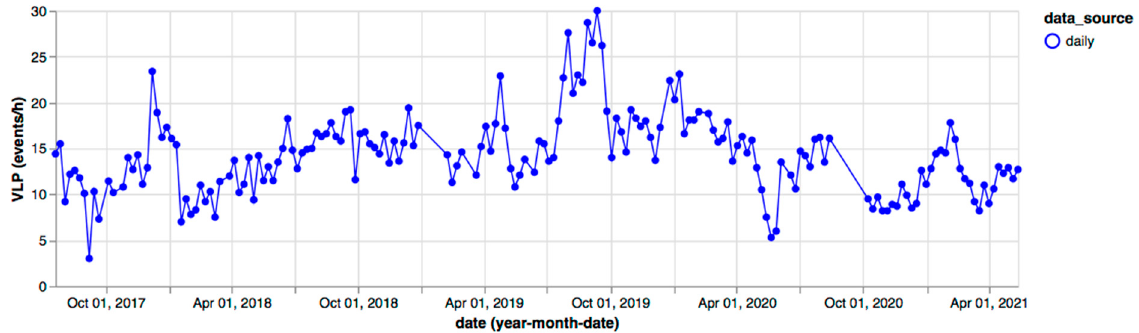
Figure 14. VLP time series for 2017–2021, extracted from LGS daily bulletins.